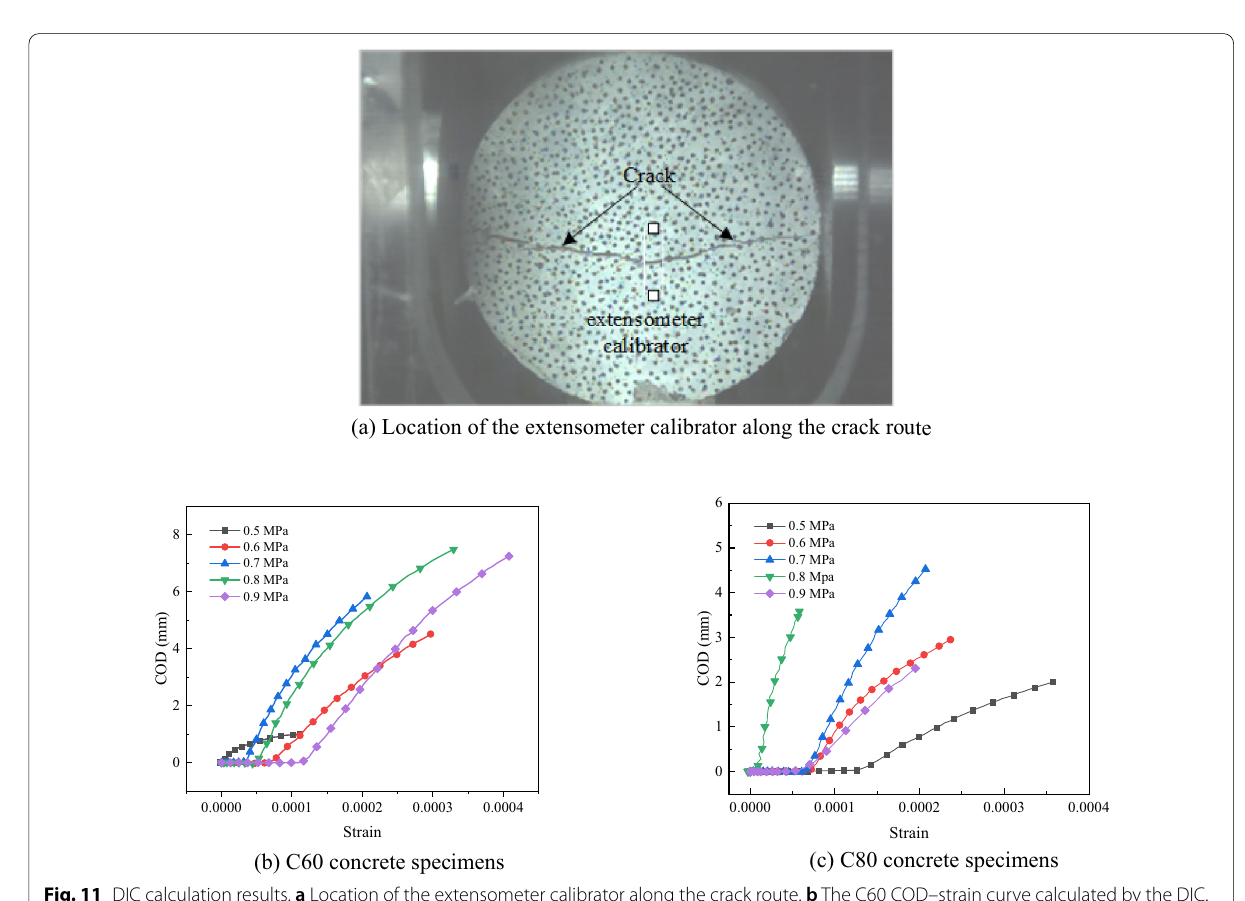
Fig. 11 DIC calculation results. a Location of the extensometer calibrator along the crack route. b The C60 COD–strain curve calculated by the DIC. c The C80 COD–strain curve calculated by the DIC.